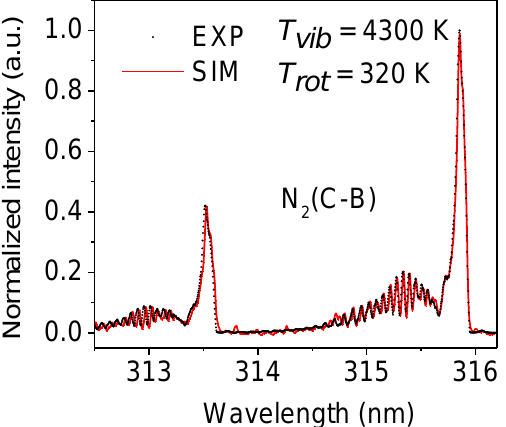
Figure 5. The measured and the best-fitting simulation spectra of N 2 (C 3 Π u → B 3 Π g , Δν = − 2).